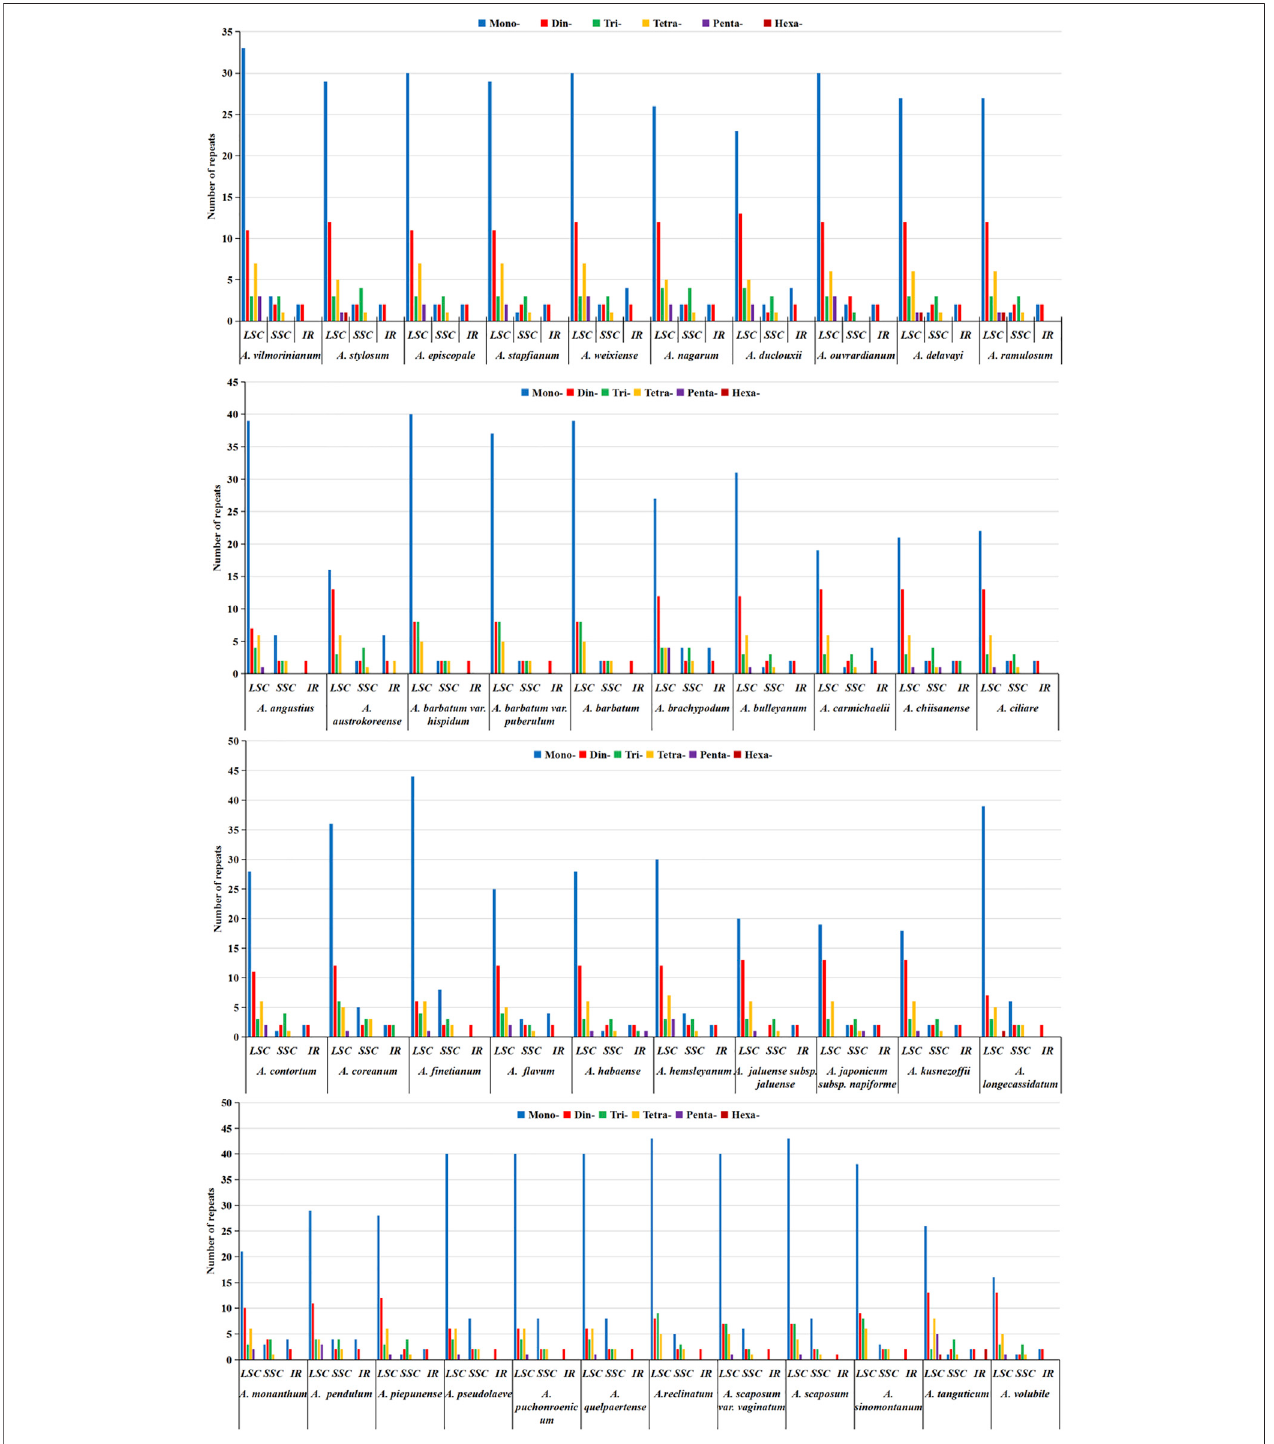
FIGURE 6 | Distribution types and numbers of SSRs in LSC, SSC, IR regions in the chloroplast genomes of 42 Aconitum spp.